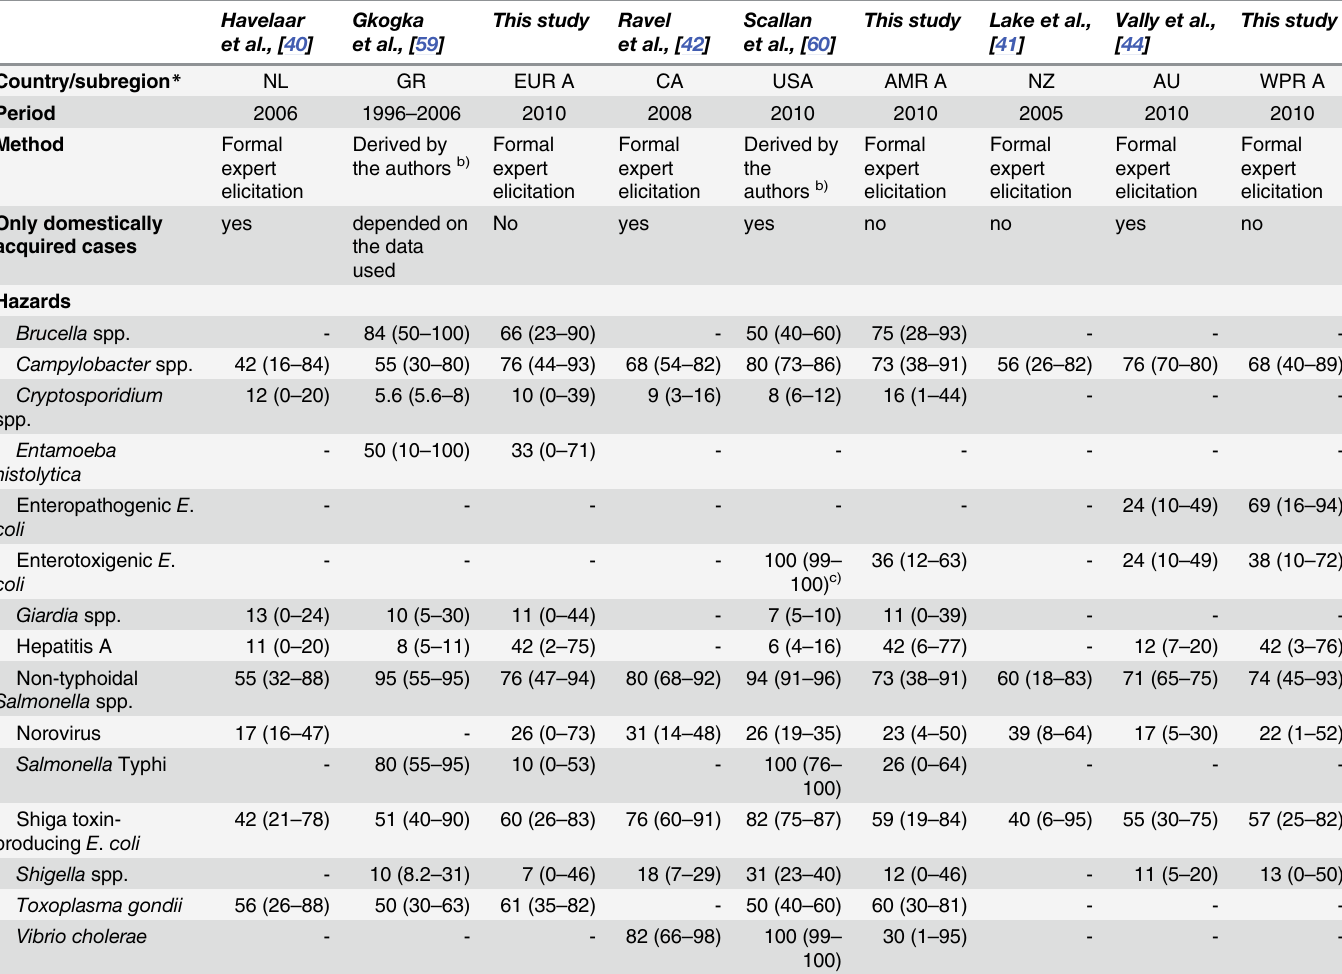
Table 10. Percent of illness acquired through the foodborne transmission route for six national studies and this study a